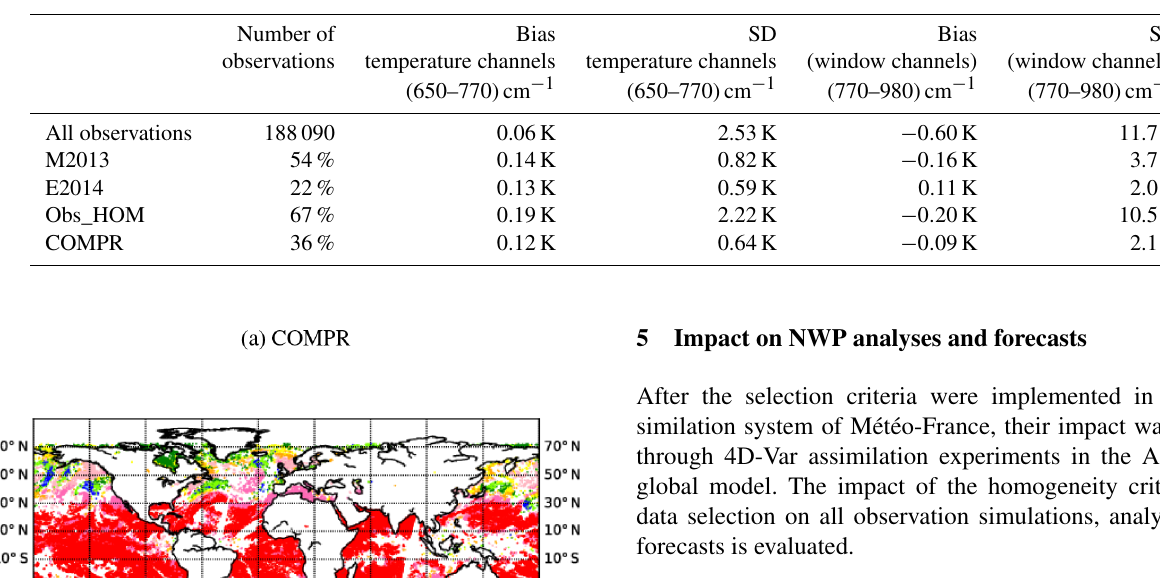
Table 4. Overview table of statistics obtained with the different homogeneity criteria: number of observations retained; bias and standard deviation computed for the channels included in the range between 650–770 and 770–980cm − 1 .